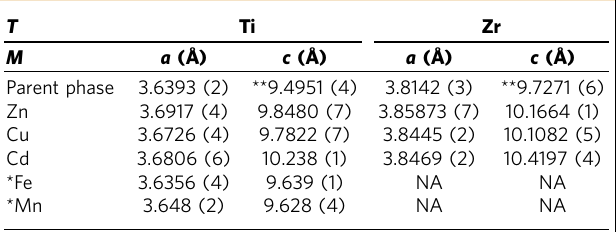
Table 1 | Lattice parameters of T 2 PTe 2 ( T ¼ Ti and Zr) and metal-intercalated M x T 2 PTe 2 .